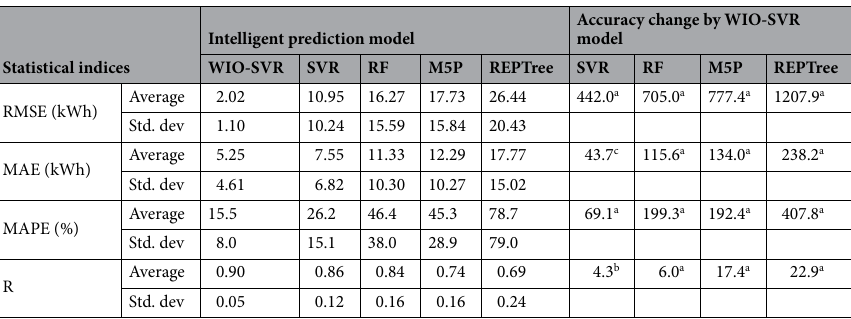
Accuracy change by WIO-SVR